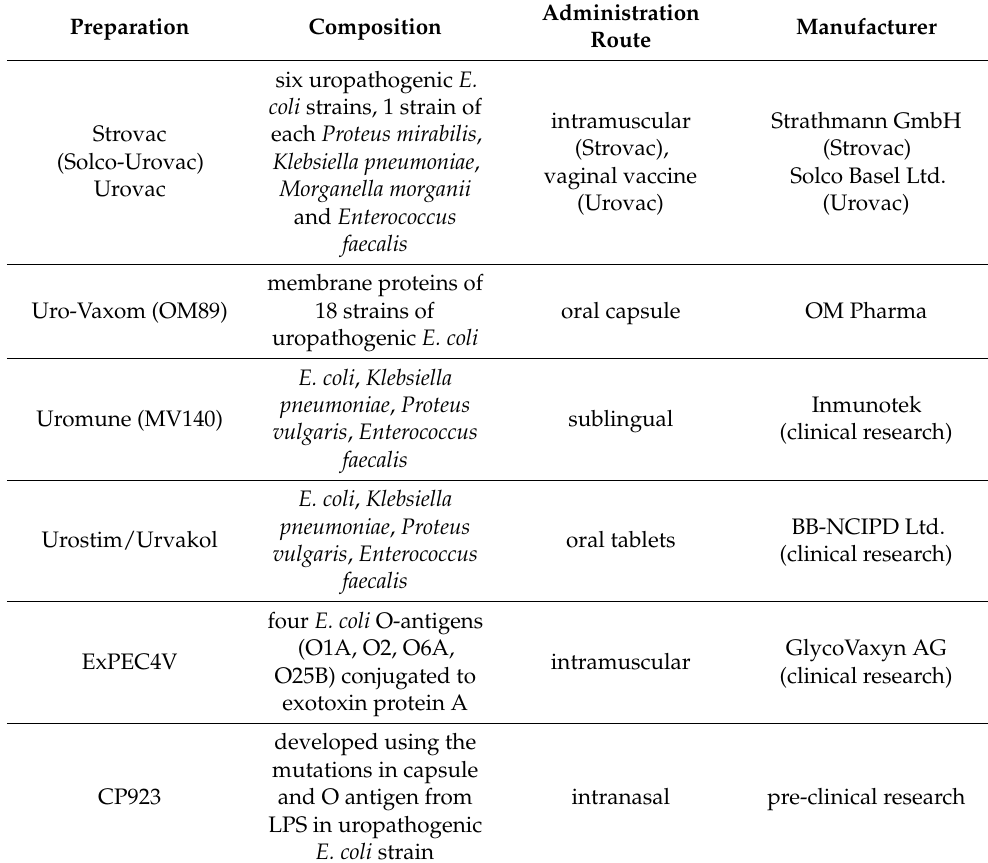
Table 2. Bacterial immunostimulants against urinary tract infection [51,74–78].